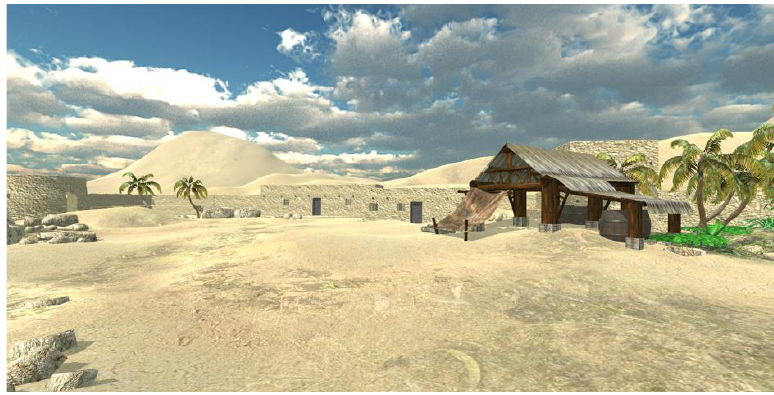
Figure 2. The scenery presented in the study.